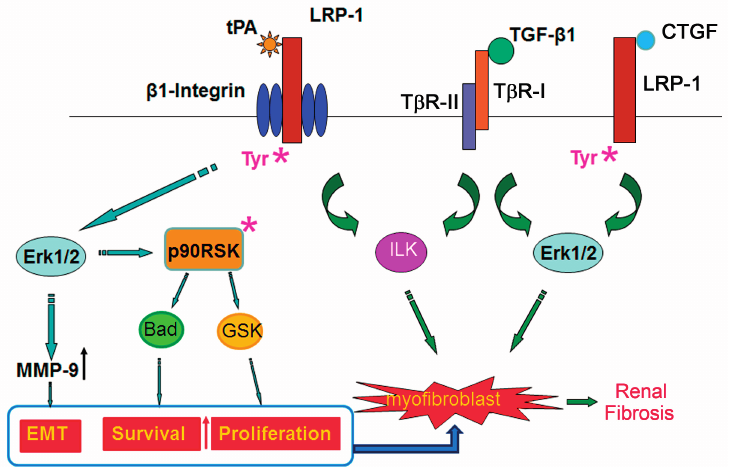
Figure 1. Fibroblast Low-density lipoprotein (LDL)-related protein-1 (LRP-1) signaling in renal fibrogenesis. Interaction of LRP-1 and its ligands mediates fibroblast